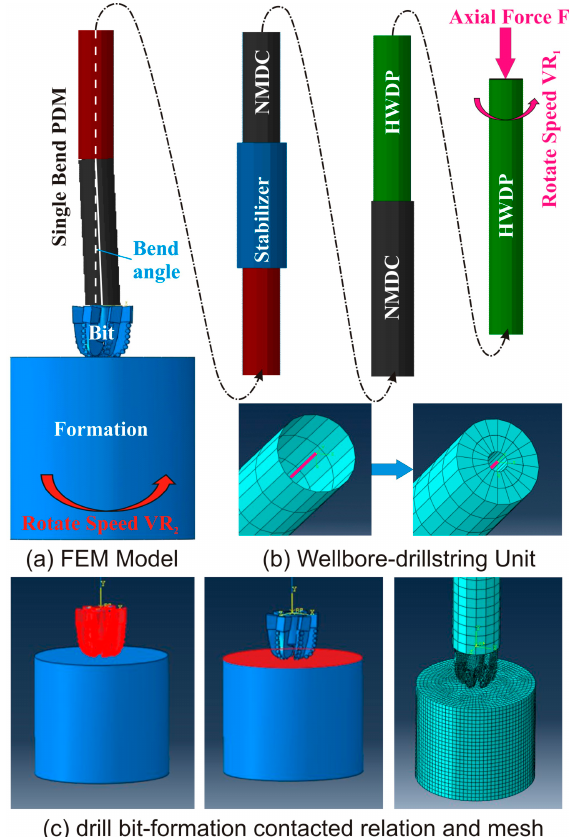
Figure 1. Sketch map of finite element model (FEM) modeling for bottom hole assembly (BHA) under fully rotary drilling: ( a ) FEM, ( b ) element of wellbore-drill-string unit, and ( c ) drill bit-formation contact relationship and meshes.